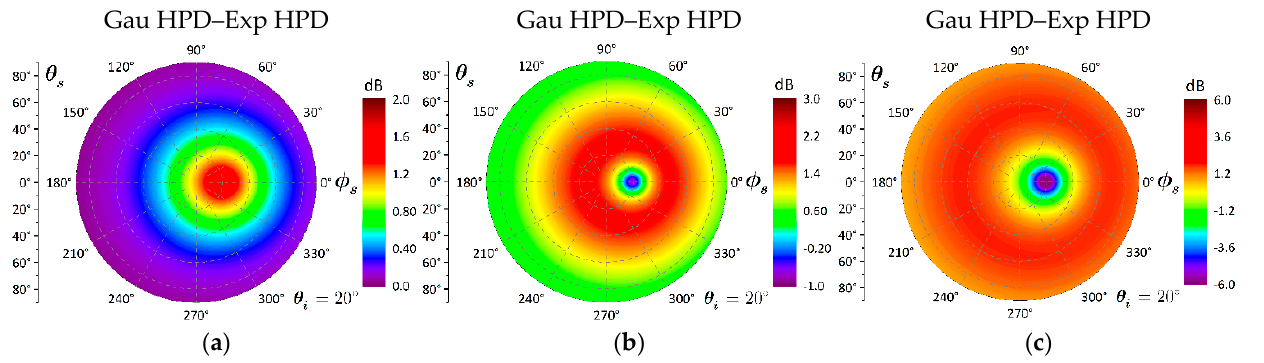
Figure 11. Difference of bistatic scattering between Gaussian and exponential HPD rough surface with exponential PSD kl = 8, k σ = 0.5,1.0,1.5, ε r = 15 − j 1.5, θ i = 20. ( a ) k σ = 0.5, ( b ) k σ = 1.0, ( c ) k σ = 1.5.